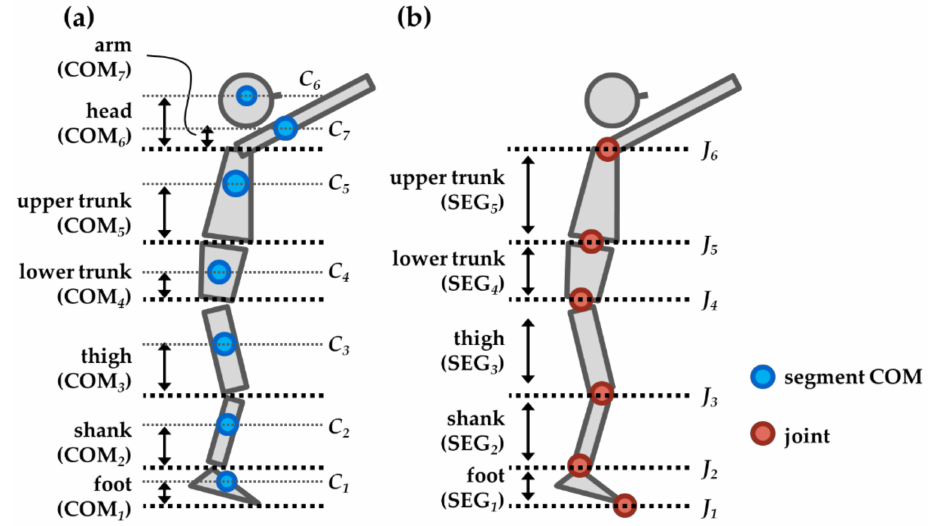
Figure 1. The definition of ( a ) vertical component of the segment center of mass length (COM k ) and ( b ) vertical component of the segment length (SEG k